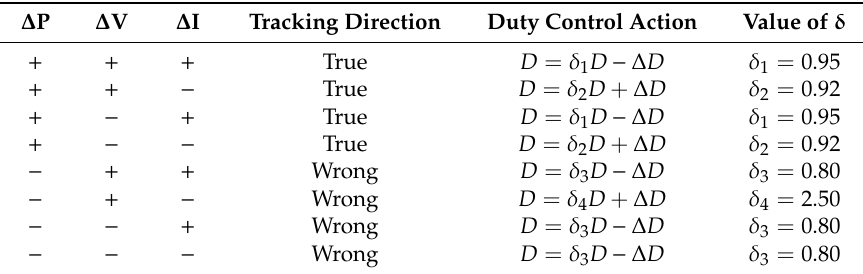
Table 1. Duty control actions of the modified algorithm.